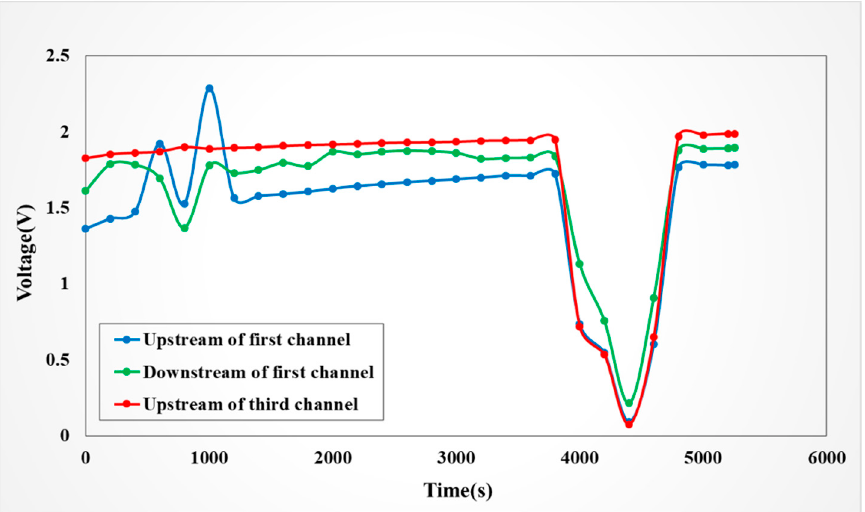
Figure 16. Voltage in anode of battery in 1A constant current charging process.